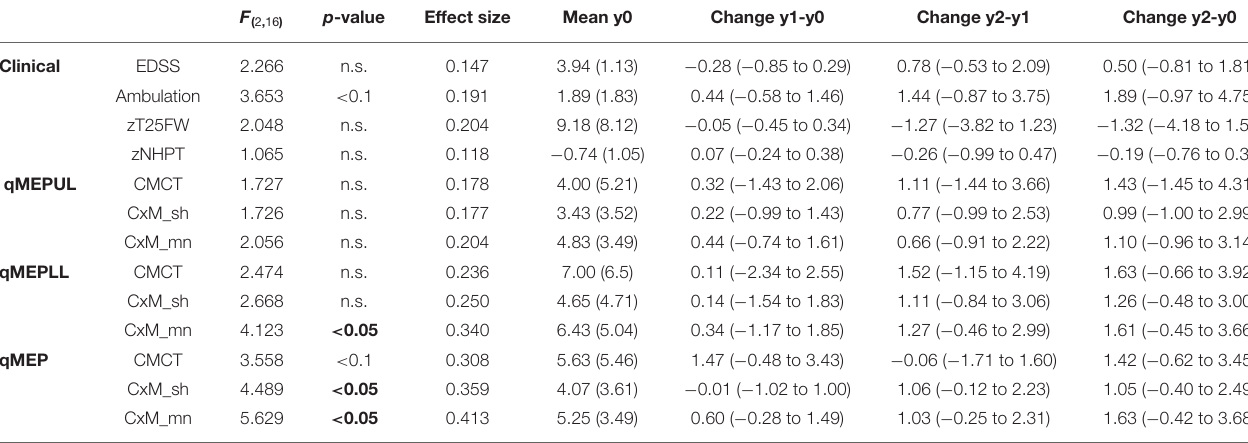
Univariate repeated measures ANOVA and post-hoc paired comparisons on all patients with complete T25FW and NHPT (n = 9) for EDSS, ambulation score, z-transformed timed 25 foot walk (zT25FW) and z-transformed nine hole peg test (zNHPT) as well as qMEP scores calculated from upper limbs (qMEP-UL), lower limbs (qMEP-LL), and the combination of both (qMEP) based on central motor conduction time (CMCT), shortest cortico-muscular latency (CxM_sh), and mean CxM (CxM_mn). For all variables, F-values, p-values (linear contrast), and effect sizes are given along with their mean values and standard deviations (SD) at baseline (y0), and their mean changes between different years with 95% confidence intervals (95%CI). Significant values are given in bold. All post-hoc comparisons were non-significant.